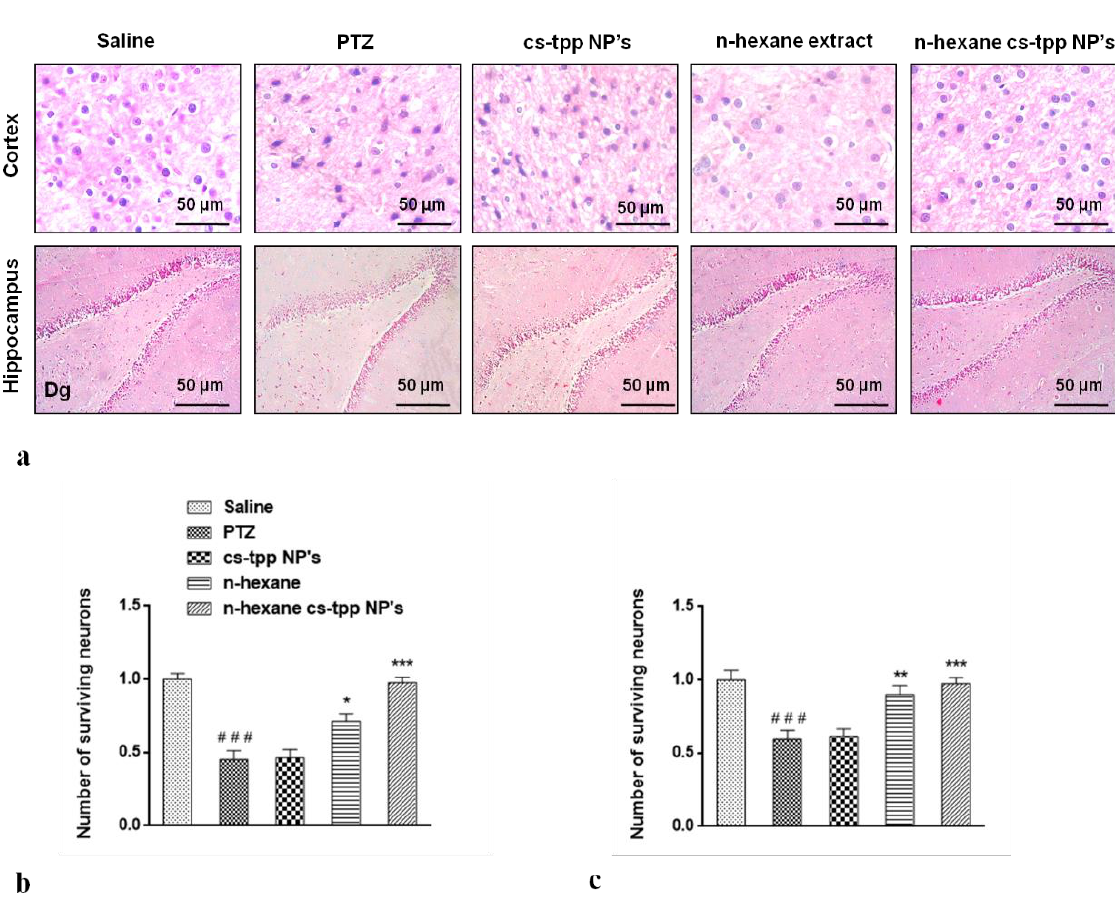
Figure 9. Slides illustrate morphological differences in the cortex and hippocampus of the brain of treated groups of animals using hematoxylin and eosin (H&E) staining ( a ). The effect on the number of neurons is evident in graphs; ( b , c )Symbols ### indicate significant difference from saline at p < 0.001 while symbols *, ** and *** shows significant difference from PTZ (disease) group at p < 0.05, 0.01 and 0.001 respectively.